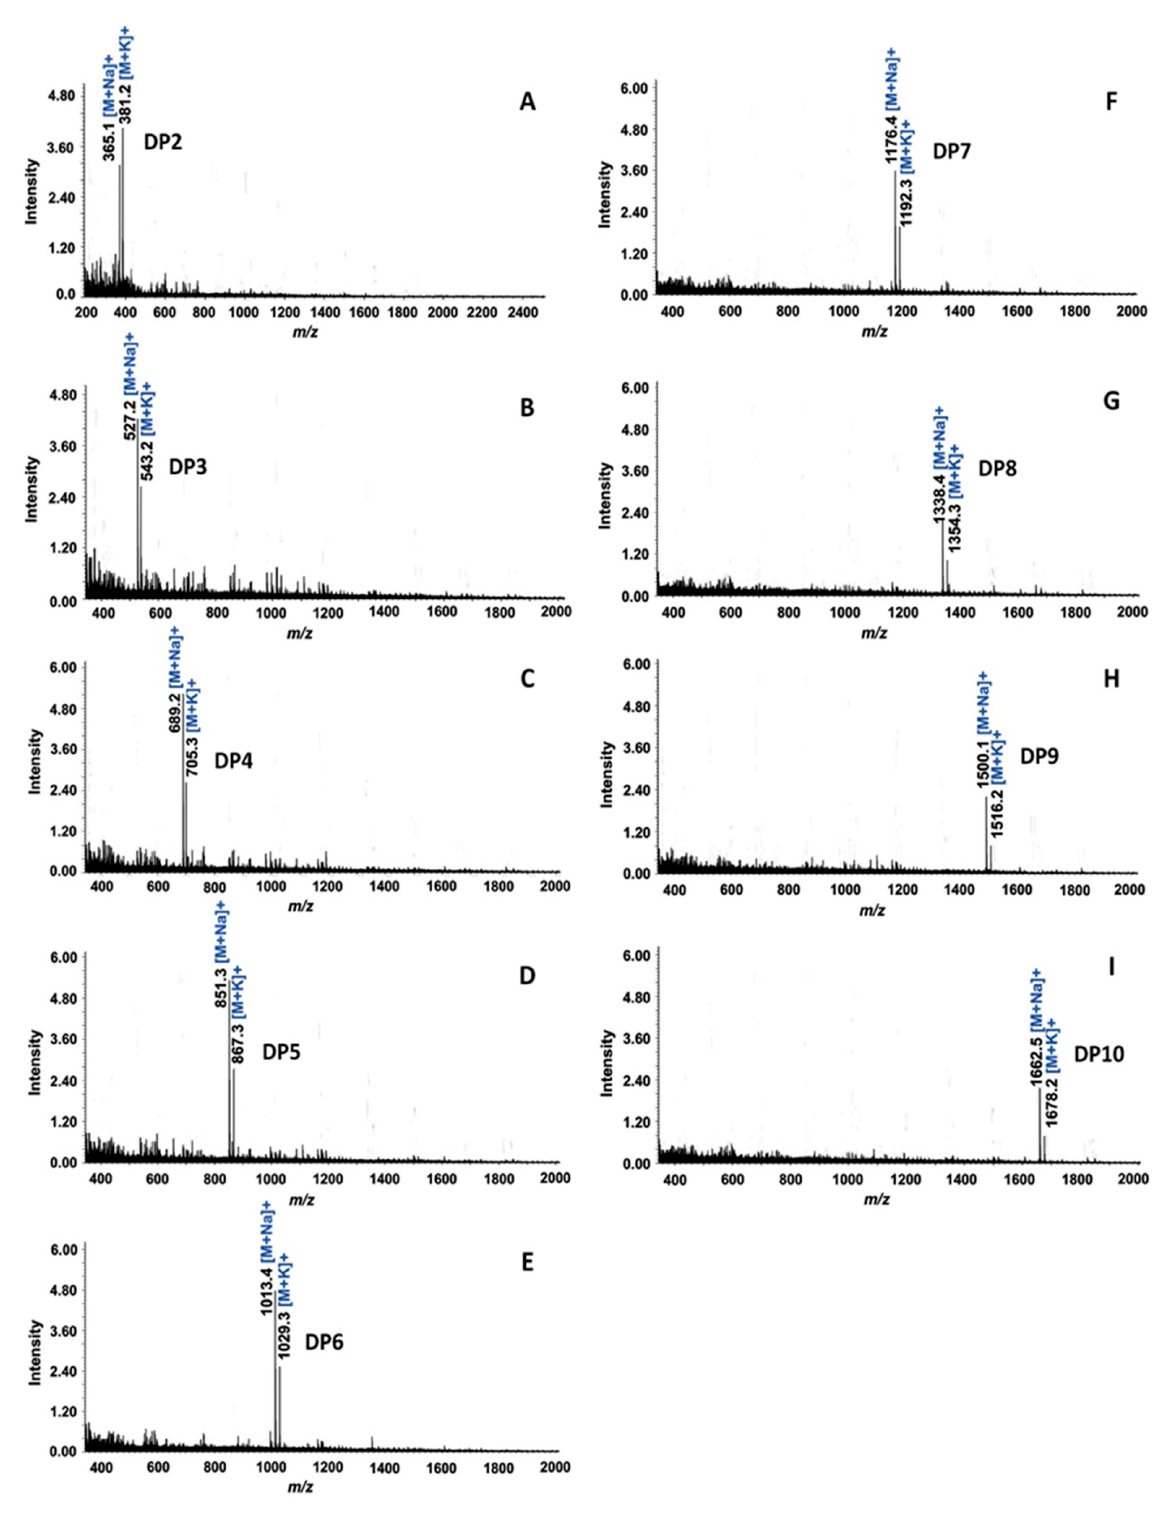
Figure 4. MALDI-TOF-MS spectra of purified IMOs produced from B. subtilis strain AP-1 with degree of polymerization (DP) as follows: ( A ) DP2, ( B ) DP3, ( C ) DP4, ( D ) DP5, ( E ) DP6, ( F ) DP7, ( G ) DP8, ( H ) DP9 and ( I ) DP10.